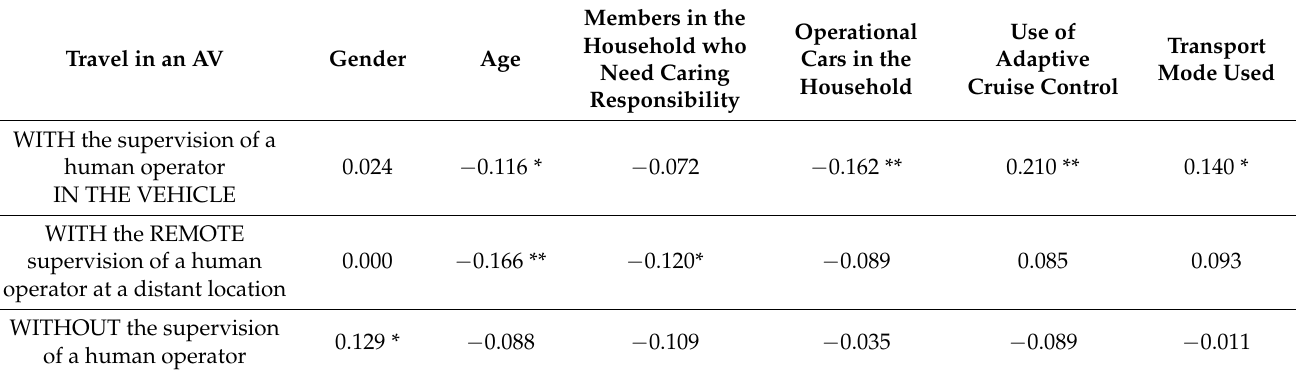
Table 6. Spearman correlation between socio-economic characteristics of the sample and potential use of AVs (Source: Authors’ survey data processing).